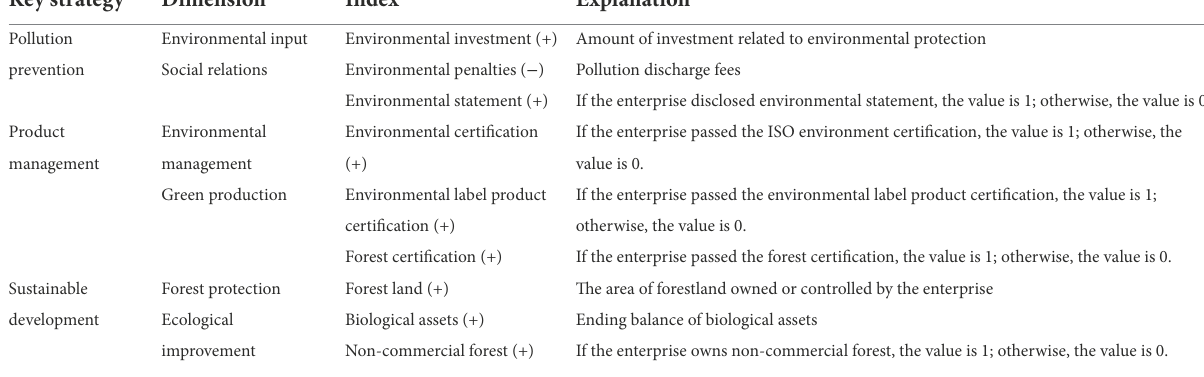
TABLE 1 Index of forestry CEER. Key strategy Dimension